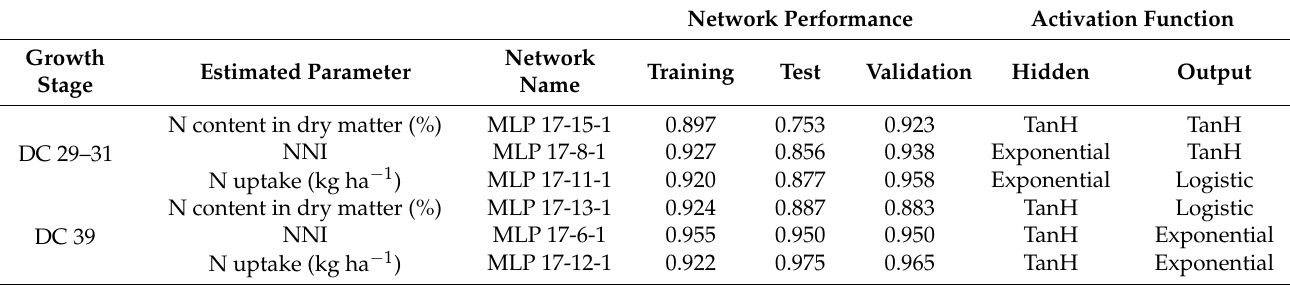
Table 4. Characteristics and performance of winning neural networks (MLP—multilayer perceptron) for estimation of individual nitrogen status parameters at growth stage DC 29–31 and DC 39. Network performance is given separately for training, test and validation datasets. Exponential, logistic, and hyperbolic tangent activation functions (TanH) are indicated for the hidden and output layer of the neural